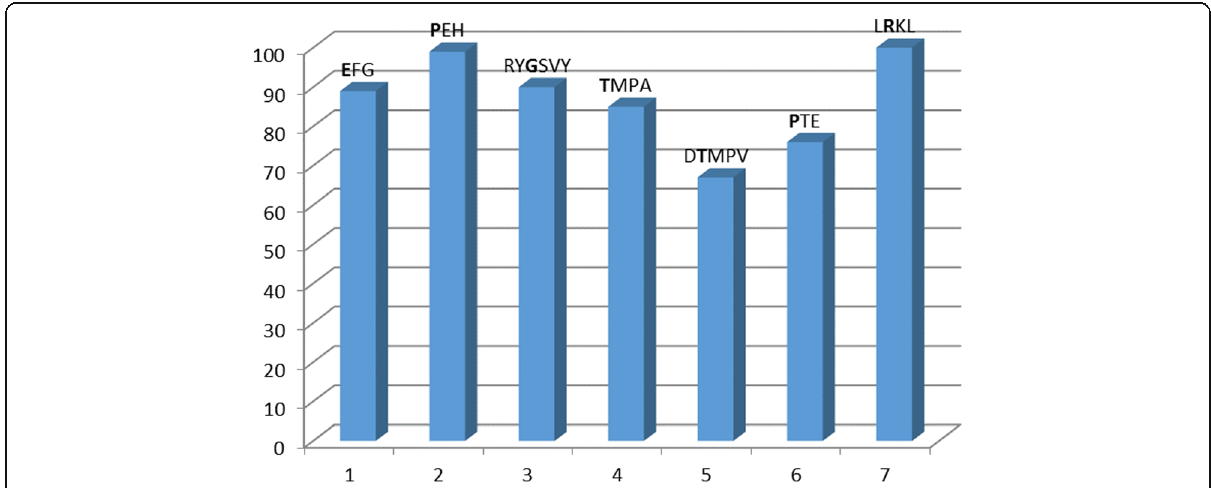
Fig. 6 Rules extracted for the PSSP model using the location of the coil